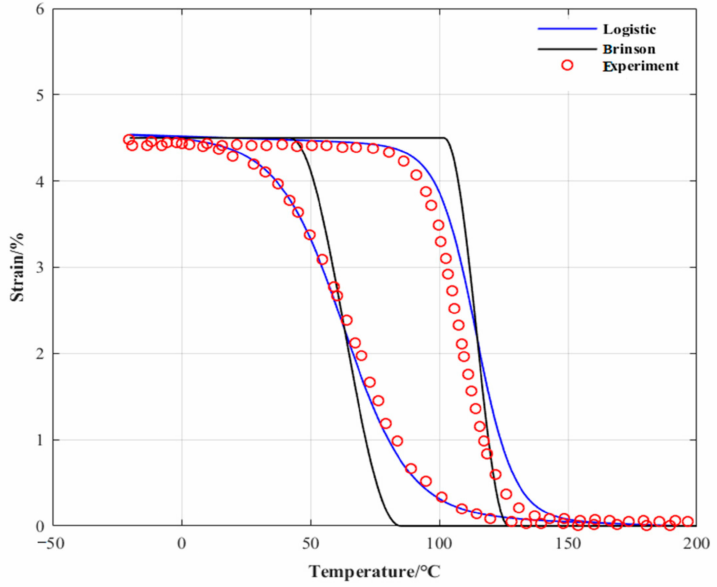
Figure 5. Comparison between the simulation and experimental results of the relationship between strain and temperature at 100